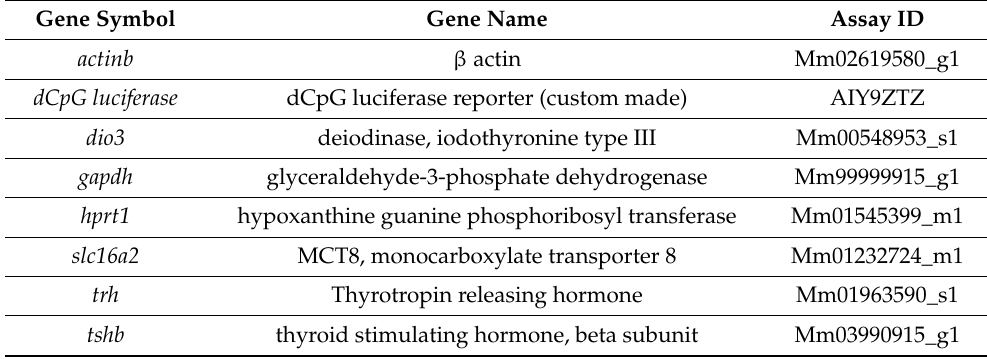
Table 1. Taqman gene expression